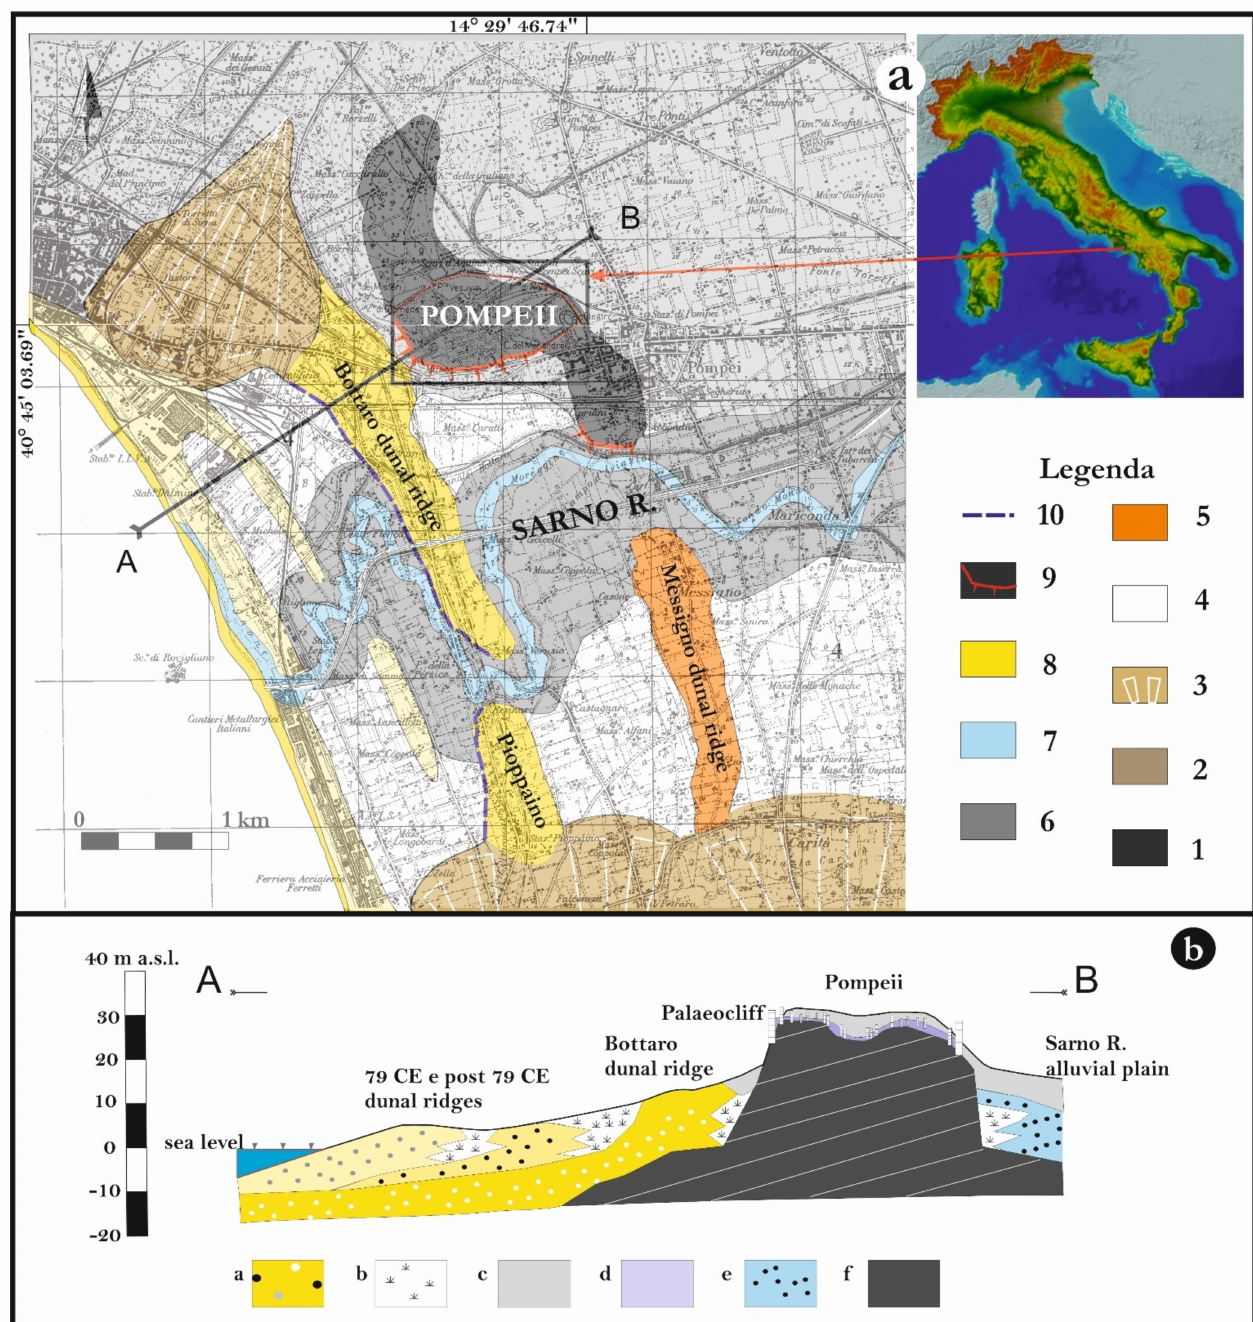
Figure 3. Geology of the Pompeii area. ( a ) Geological map (1:25,000 in scale) of the Sarno river alluvial coastal plain. (1) Pompeii Volcano Lava (late Pleistocene); (2) late Holocene volcaniclastic deposits; (3) late Holocene alluvial fan deposits; (4) Holocene lagoonal, marshy deposits; (5) Holocene dunal deposits; (6) Holocene fluvial deposits; (7) 1800 AD Sarno river paleocourse; (8) Nowadays beach deposits; (9) Early Holocene Pompei paleocliff; (10) 79 AD paleoshoreline; ( b ) Schematic geological cross-section (trace AB) showing a stratigraphic assessment of the subsoil: (a) sandy coastal deposits; (b) silty-clay marshy and lagoonal deposits; (c) 79 CE eruption deposits; (d) alternating of paleosols, volcaniclastic deposits, and weathered lava; (e) Sarno river fluvial deposits; (f) Pompeii volcano lava. The ancient city was built on the relics of an ancient volcanic cone, named Pompei Volcano by Cinque and Irollo [23], interpreted as a coalescence of more craters and